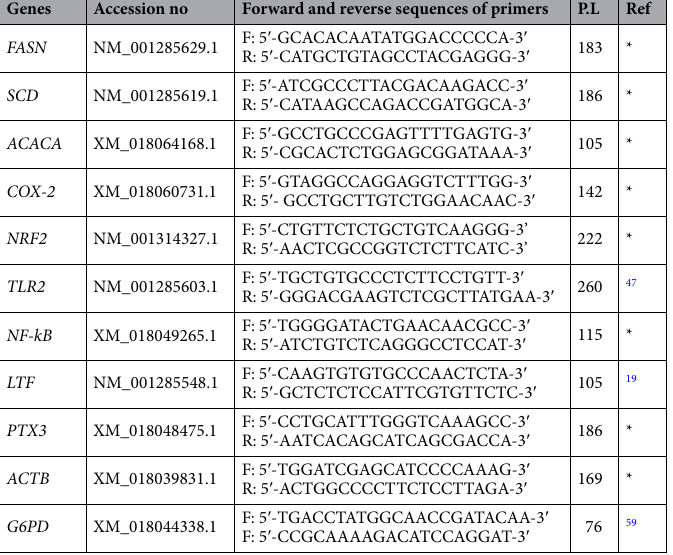
Table 4. Forward and reverse sequences of primers amplified genes; *: Designed by authors, P.L.: Product Length; FASN: Fatty Acids Synthase; SCD: Stearoyl-CoA Desaturase; ACACA: Acetyl-CoA Carboxylase Alpha; COX-2: Cyclooxygenase-2; TLR2: Toll-like Receptor 2; NF-kB: Nuclear factor Kappa B; LTF: Lactoferrin; PTX3: Pentraxin 3; NRF2: Nuclear Factor Erythroid 2-related Factor 2; ACTB: Actin-beta; G6PD: Glucose-6- phosphate